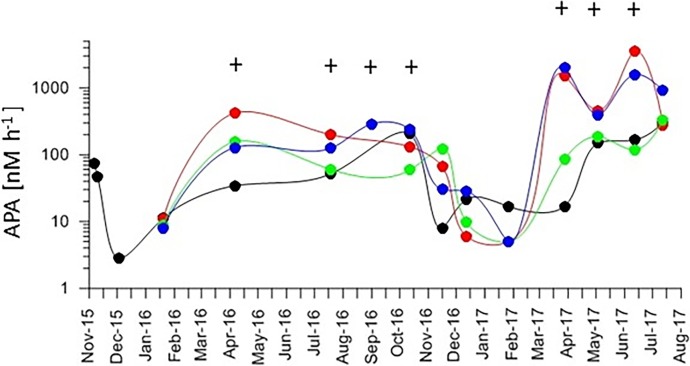
Alkaline phosphatase activity in water samples between November 2015 and August 2017 at different longitudes across the northern Adriatic.Blue (12.75), red (12.83), green (13.31), black (13.61) (see positions indicated by correspondingly colored arrows in Fig 1). Crosses mark sampling dates when C. peruvianus cells were found in in situ samples to show extracellular alkaline phosphatase activity. Their activity pattern followed the general trend of alkaline phosphatase activity in water samples throughout the year.